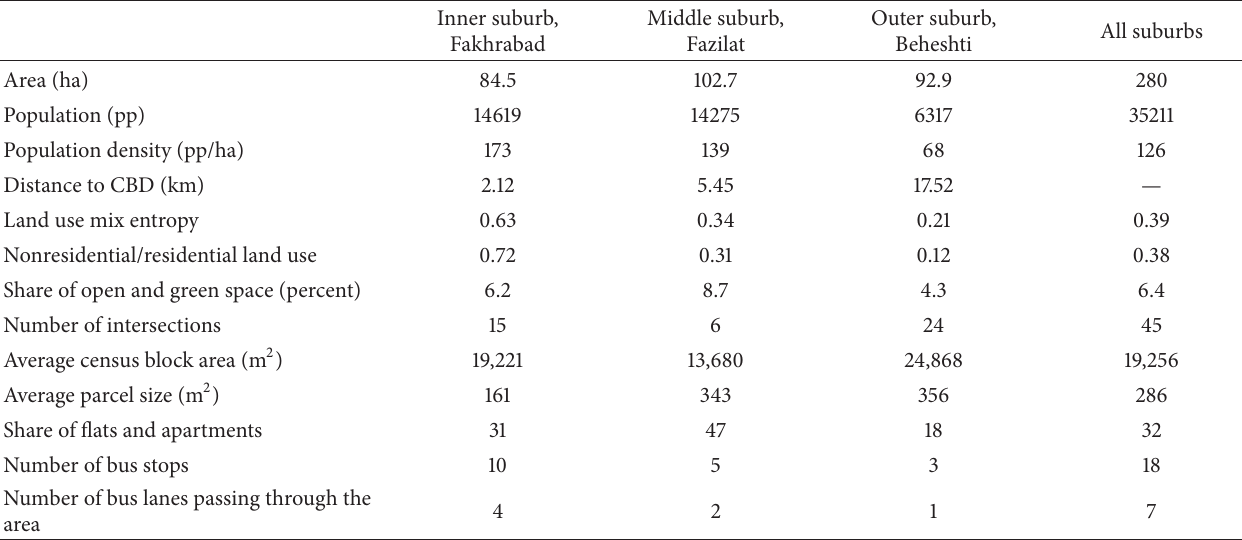
Table 1: Built environment measure for the three studied